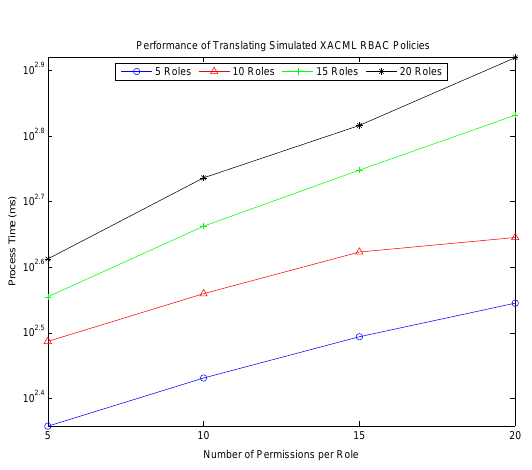
Figure 10. Runtimeperformanceof ourTranslationTool. included on each role. All roles in the policy belonged to the same role hierarchy and the same permission was allowed to be assigned to at most two roles. As expected, the execution time depicted by our tool remains linear as the size of the policy given as an input is